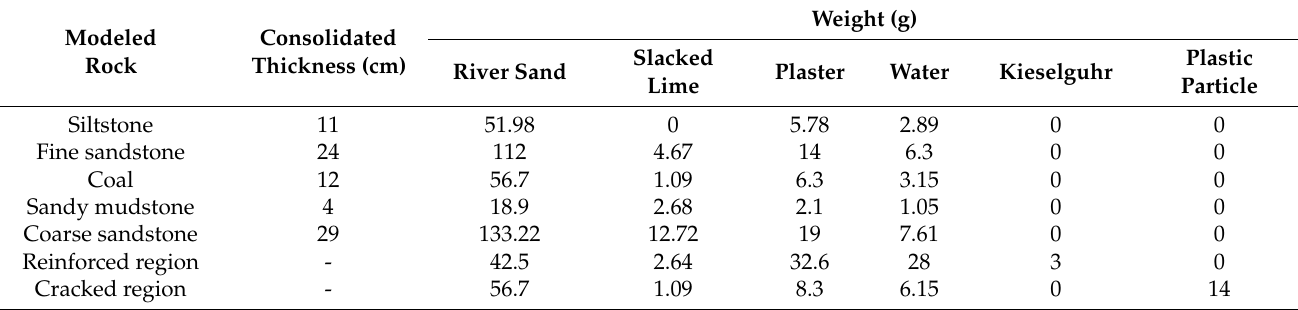
Table 4. Similar materials of rock layers and modified regions of a coal